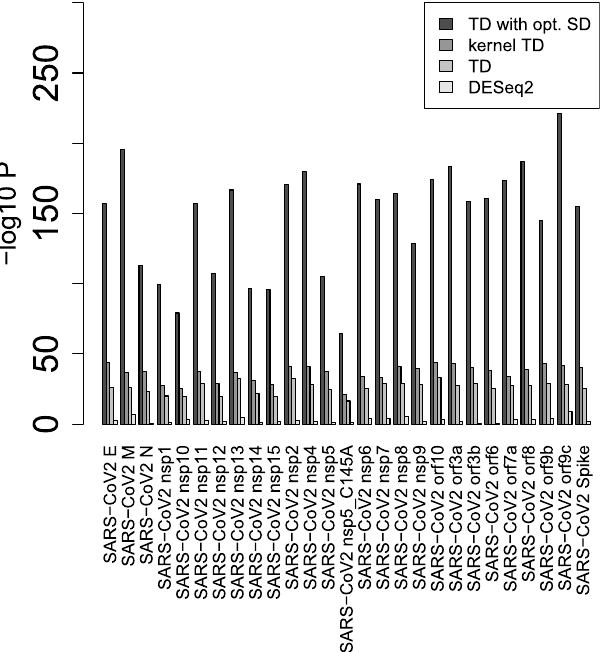
Figure 14. P values computed by Fishers’ exact test to evaluate the overlap between human genes known to interact with SARS-Cov-2 proteins and genes selected by various methods. DESeq2 is only for A549 cell lines.